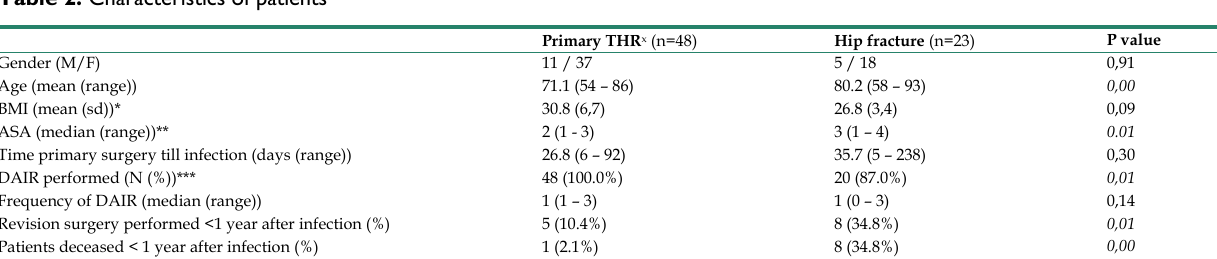
Figure 2. Prosthesis survival until 1 year after infection: primary THR versus hip fracture surgery Table 2. Characteristics of